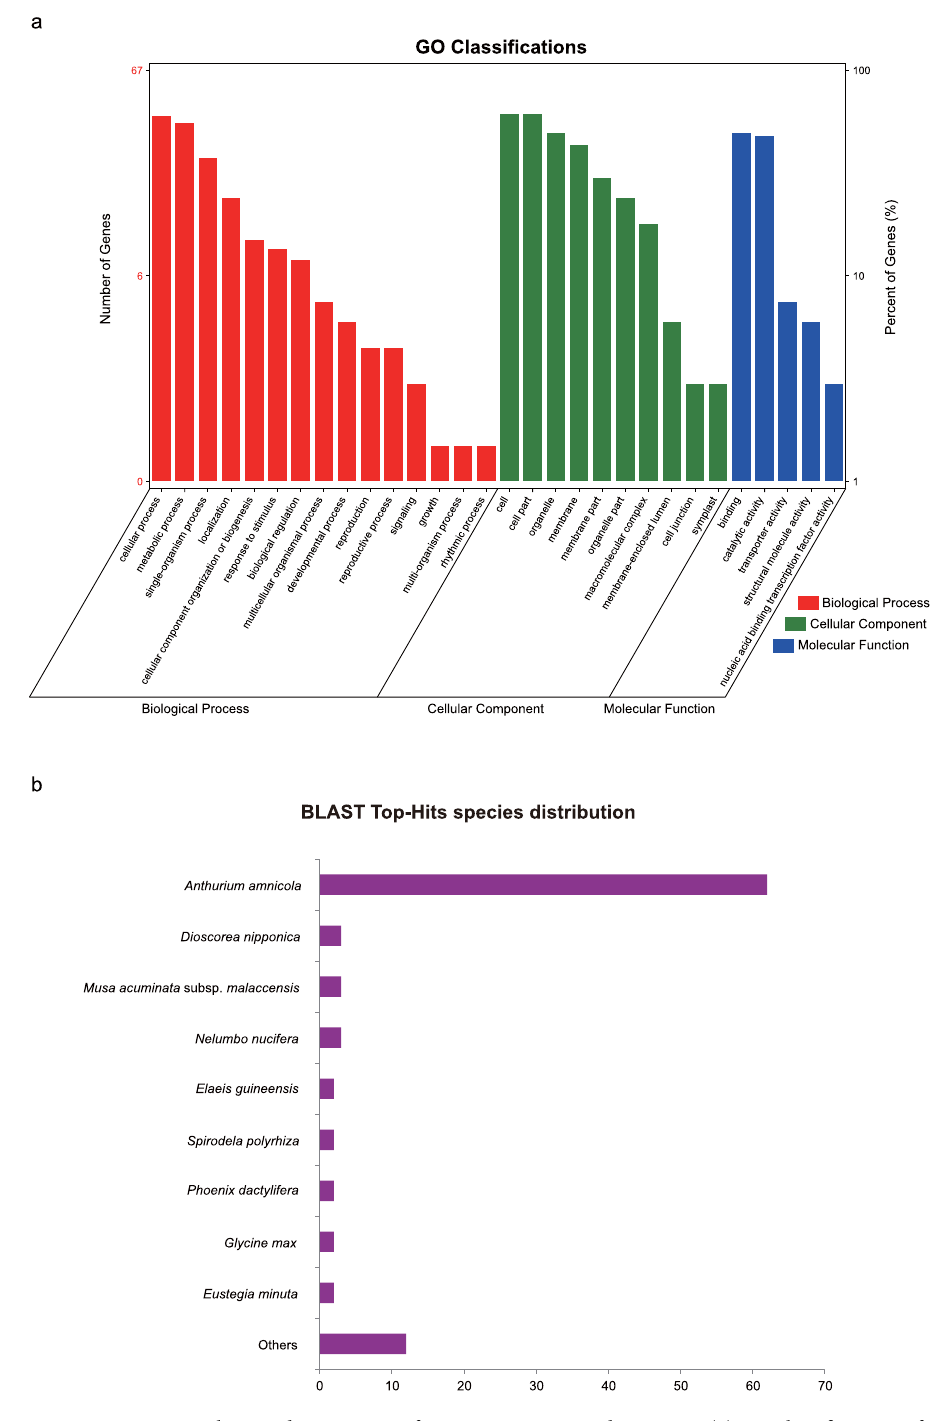
Figure 4. Gene ontology and annotation of genic SNP-associated unigenes. ( a ) GO classifications of identified genic SNP-associated unigenes. ( b ) Frequency and distribution of matched species of significant BLASTX hits (E-value ≤ 1e − 6